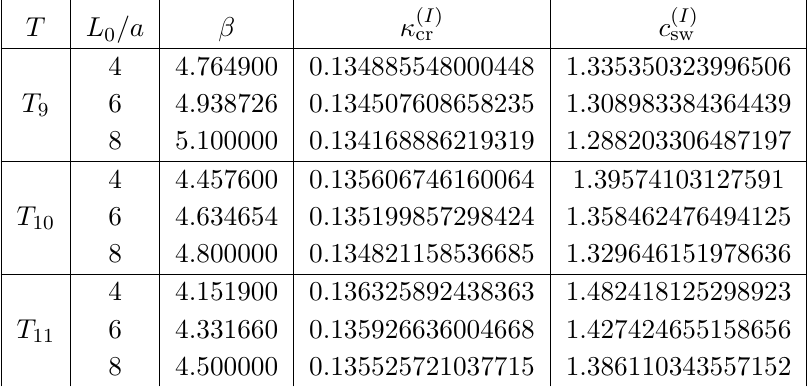
. 0 we consider the 1